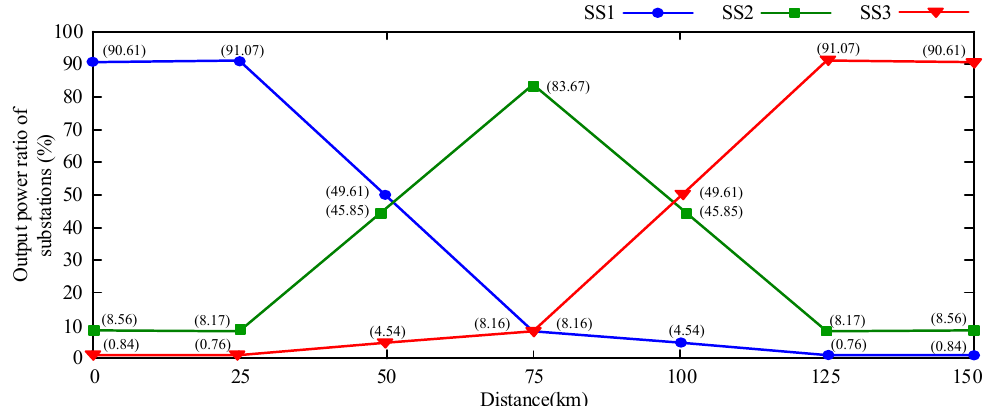
Figure 11. The relationship between the location of the locomotive and the output power ratio of the traction substation.